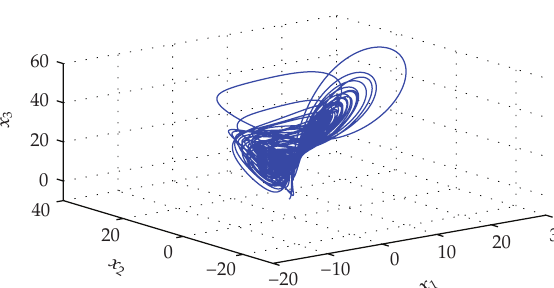
Figure 1: The phase plane trajectory of uncontrolled uncertain unified chaotic system when α 0 (cid:8) 0 . 5 and p 1 (cid:8) 0 . 49 × sin (cid:2) t (cid:3) .